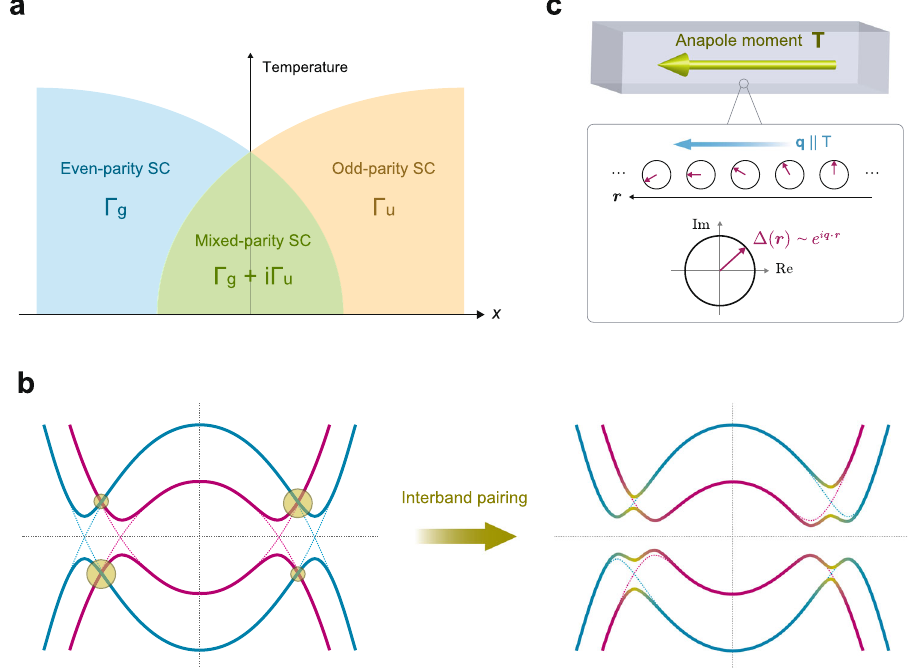
Fig. 1 Schematics of PT -symmetric mixed-parity superconductivity (SC). a Schematic phase diagram in a superconductor with comparable strength of even- and odd-parity pairing interactions. The transition between the even-parity superconducting phase ( Γ g ) and the odd-parity superconducting phase ( Γ u ) is induced by tuning a control parameter x . For centrosymmetric systems with T -symmetry, there is generally an intermediate mixed-parity superconducting phase ( Γ g + i Γ u ) where even- and odd-parity pairing components are coexistent with the relative phase difference ± π /2. b Illustration for a mechanism of the asymmetric Bogoliubov spectrum (BS) in PT -symmetric mixed-parity multiband superconductors. P - and T -symmetry breaking interband pairing induces an asymmetric modulation of the BS. c Schematic fi gure of the anapole superconducting states. In real space, the phase of the superconducting order parameter Δ ( r ) becomes nonuniform along a direction parallel to the effective anapole moment T as Δ ( r ) ∝ e i q ⋅ r with q ∥ T , where q is the center-of-mass momentum of Cooper